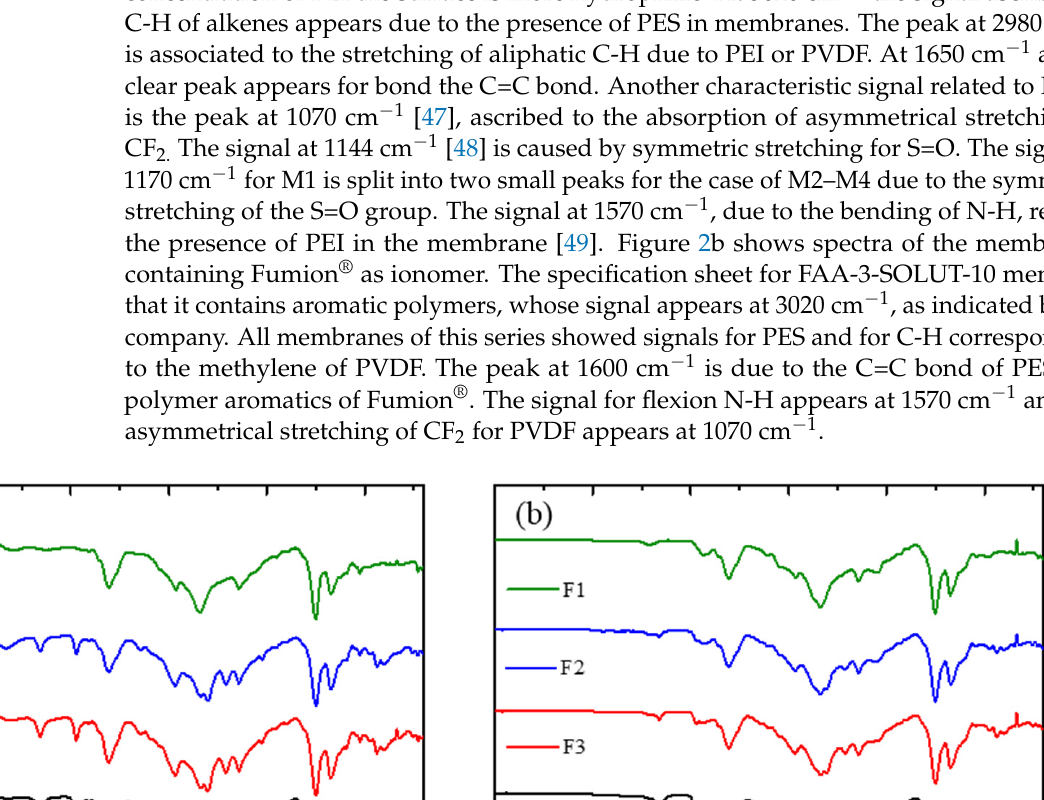
Figure 2. FT-IR spectra of the synthesized membranes containing: ( a ) PEI and ( b ) Fumion ® .